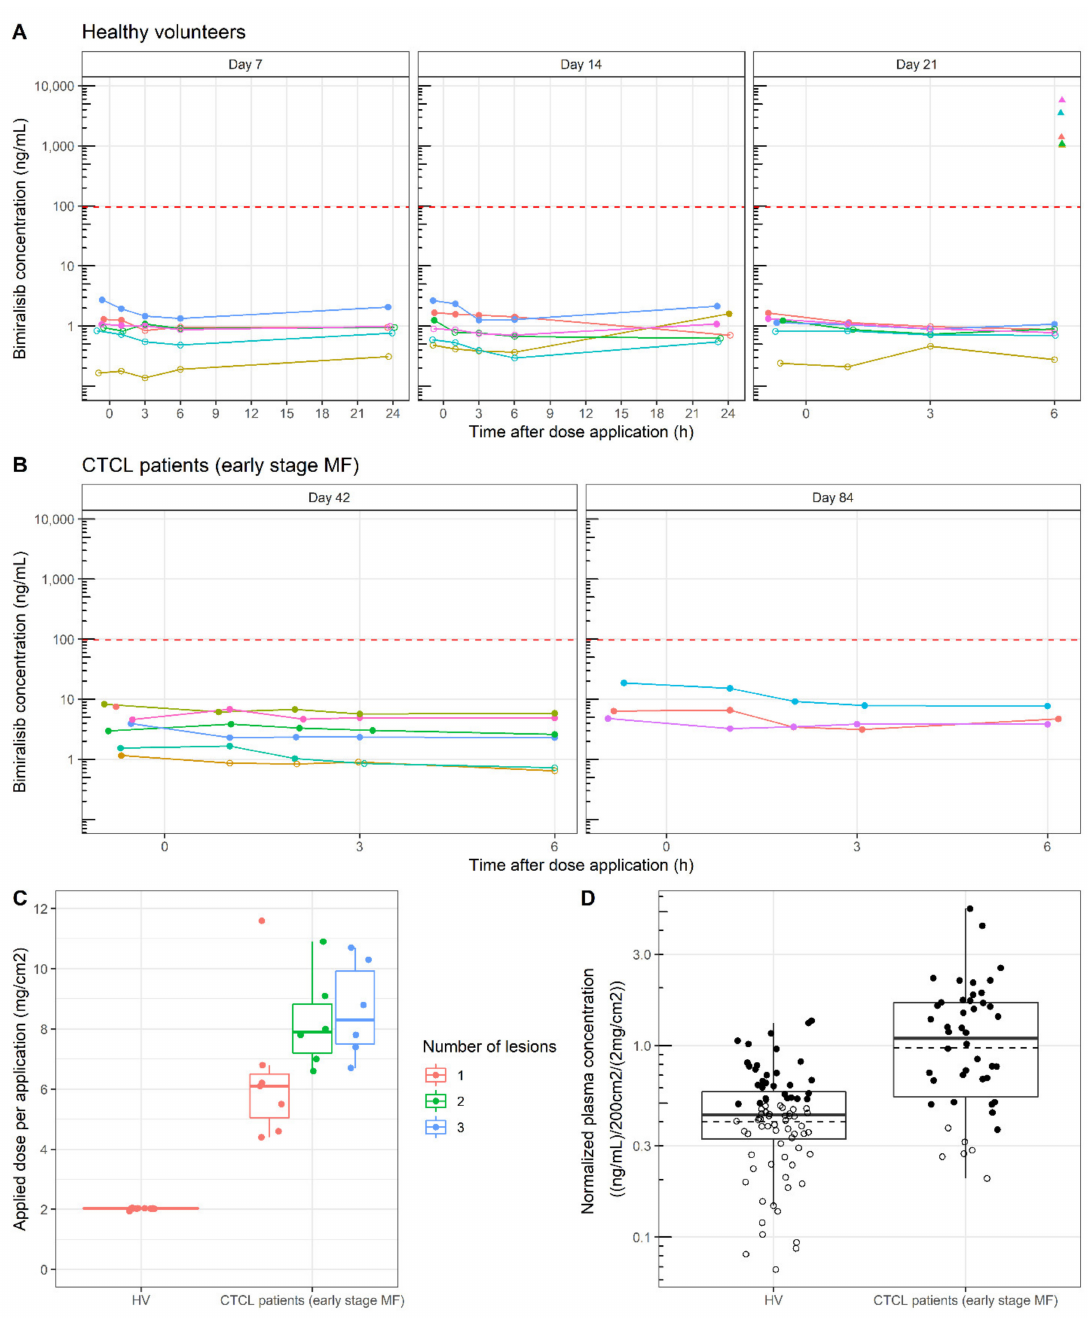
Figure 4. Bimiralisib pharmacokinetics in HVs and early-stage MF patients. ( A ) Individual plasma concentrations of 6 healthy volunteers after 7, 14 and 21 days of topical daily application ranged from 0.14 to 2.74 ng/mL. The red dotted line is the NOAEL Cmax (96.6 ng/mL). ( B ) Individual plasma concentrations of 9 MF patients, 6 patients after 42 days of daily topical application and 3 patients after 84 days of bimiralisib application. Concentrations ranged from 0.67 to 18.70 ng/mL. ( C ) Applied dose per application increased with increasing target lesions, as shown by exploratory analysis. Patients with a single target lesion applied less gel per dose (6.5 ± 2.4) in comparison to patients with two (8.2 ± 1.6) or three (8.6 ± 1.6) target lesions. ( D ) Normalized plasma concentration was 2.44-fold higher for patients compared to healthy volunteers. Boxplots show the first, median and third quartiles in the box; whiskers extend up to 1.5 × the interquartile range. Dashed line is the log-transformed mean. Open dots are data below the LLOQ (1.0